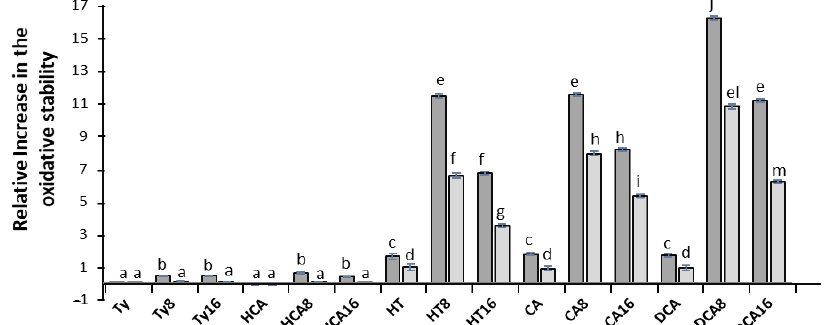
Figure 4. Relative increase in the oxidative stability of 4:6 (O/W) emulsions (olive oil/citrate buffer, 0.04 M, pH = 3.65/Tween 20) containing the antioxidants prepared with emulsifier fractions of Φ I = 0.005 (dark grey color) and Φ I = 0.01 (light gray color) Mean (error represent the standard deviation) of triplicate stored samples ([AO T ] = 0.24 mM, T = 60 ◦ C). Superscripts indicate samples that were significantly different ( p < 0.05).